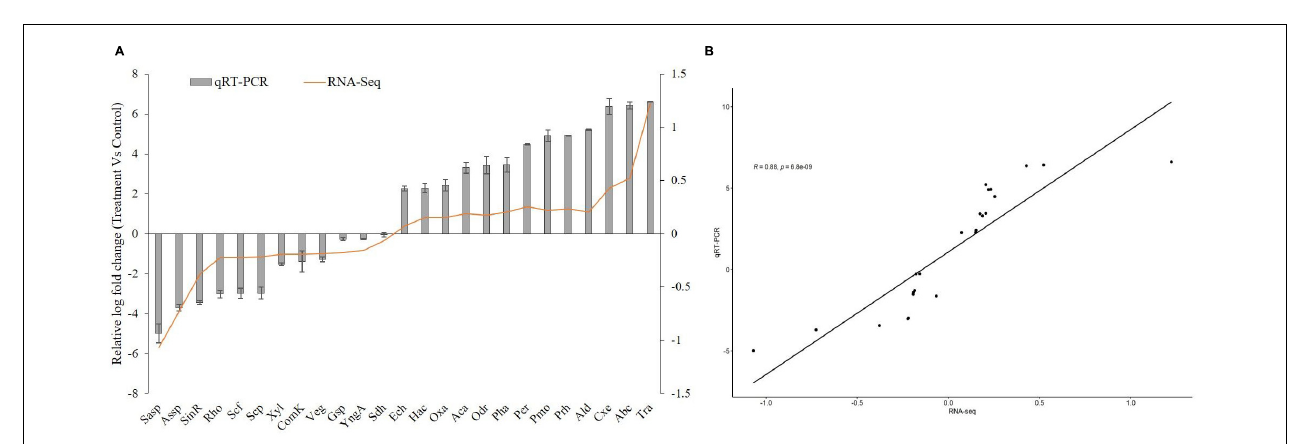
FIGURE 8 | Top 20 KEGG pathways during PET utilization by Bacillus species AIIW2.